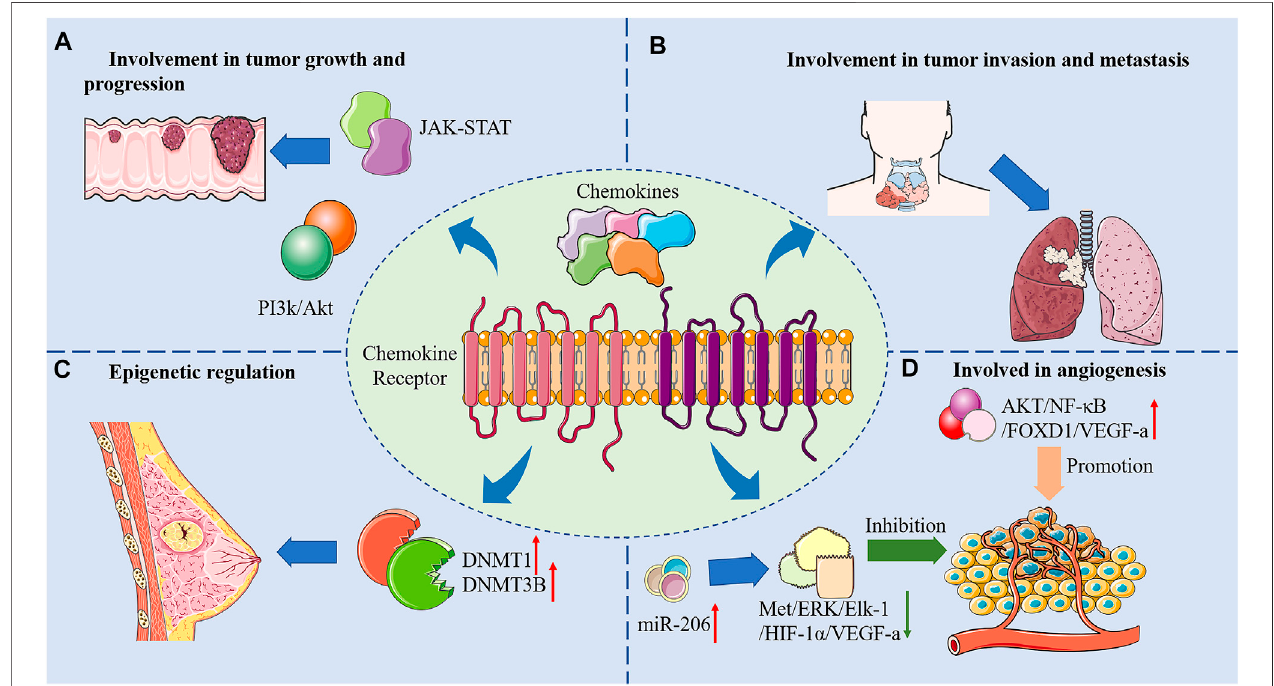
FIGURE 2 | Mechanisms of anti-tumor effects of chemokines and its receptors.